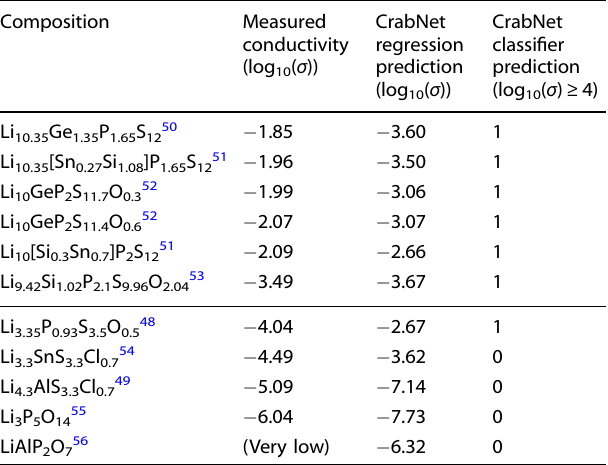
Table 5. Final regression and classi fi cation model predictions of the experimental holdout